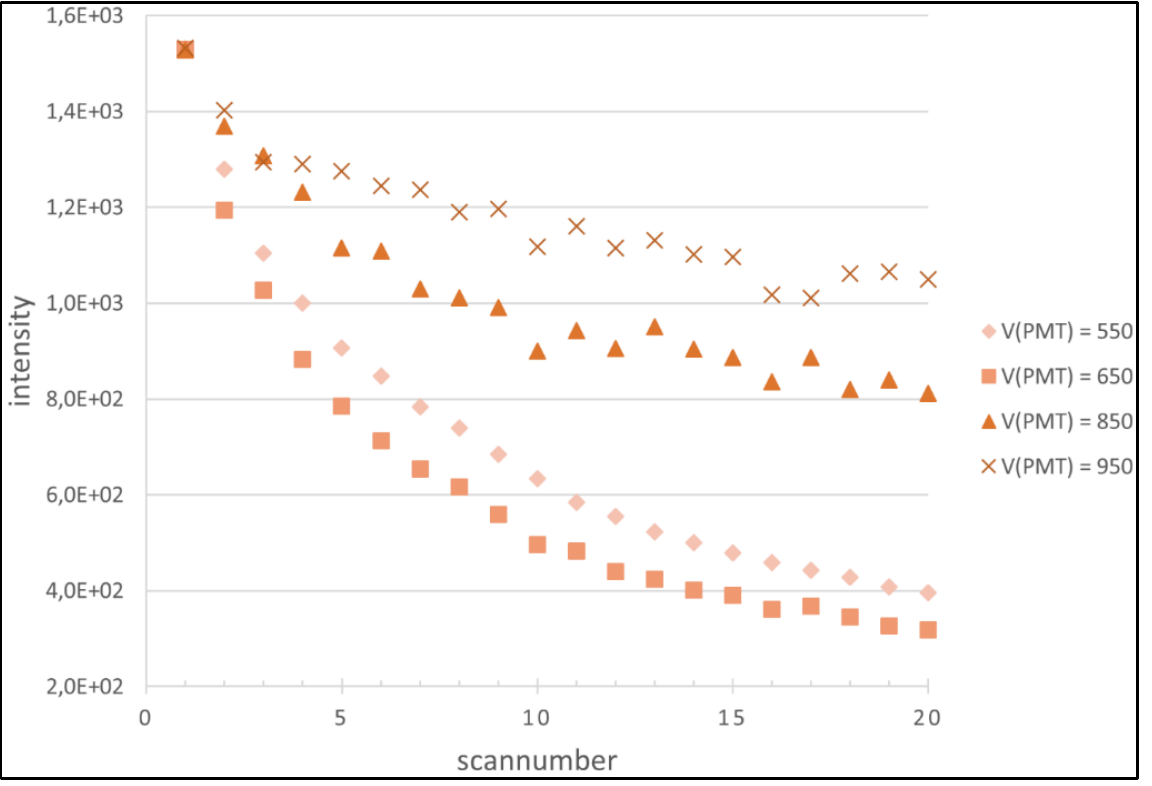
Figure 2. Change in measured intensity of Cy5-labeled cDNA spots of equal initial intensity with increasing number of scans, depending on the PMT